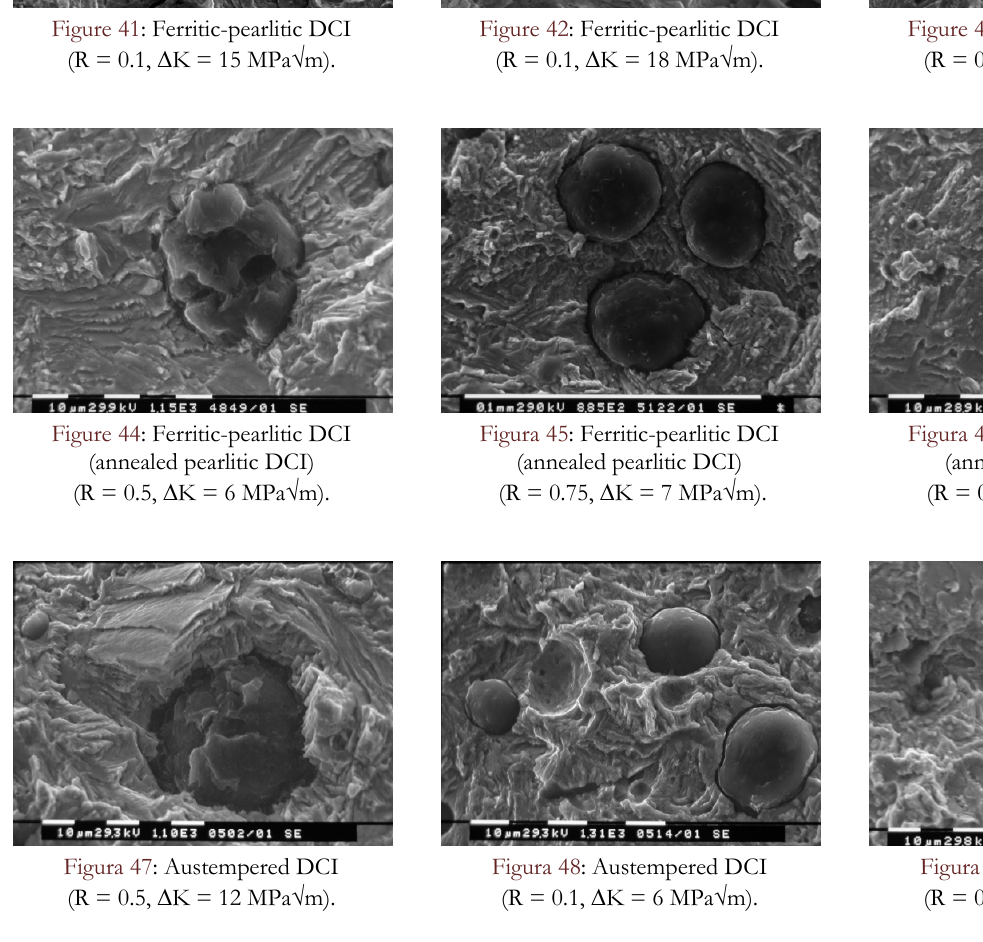
Figura 49: Austempered DCI (R = 0.1,  K = 18 MPa √